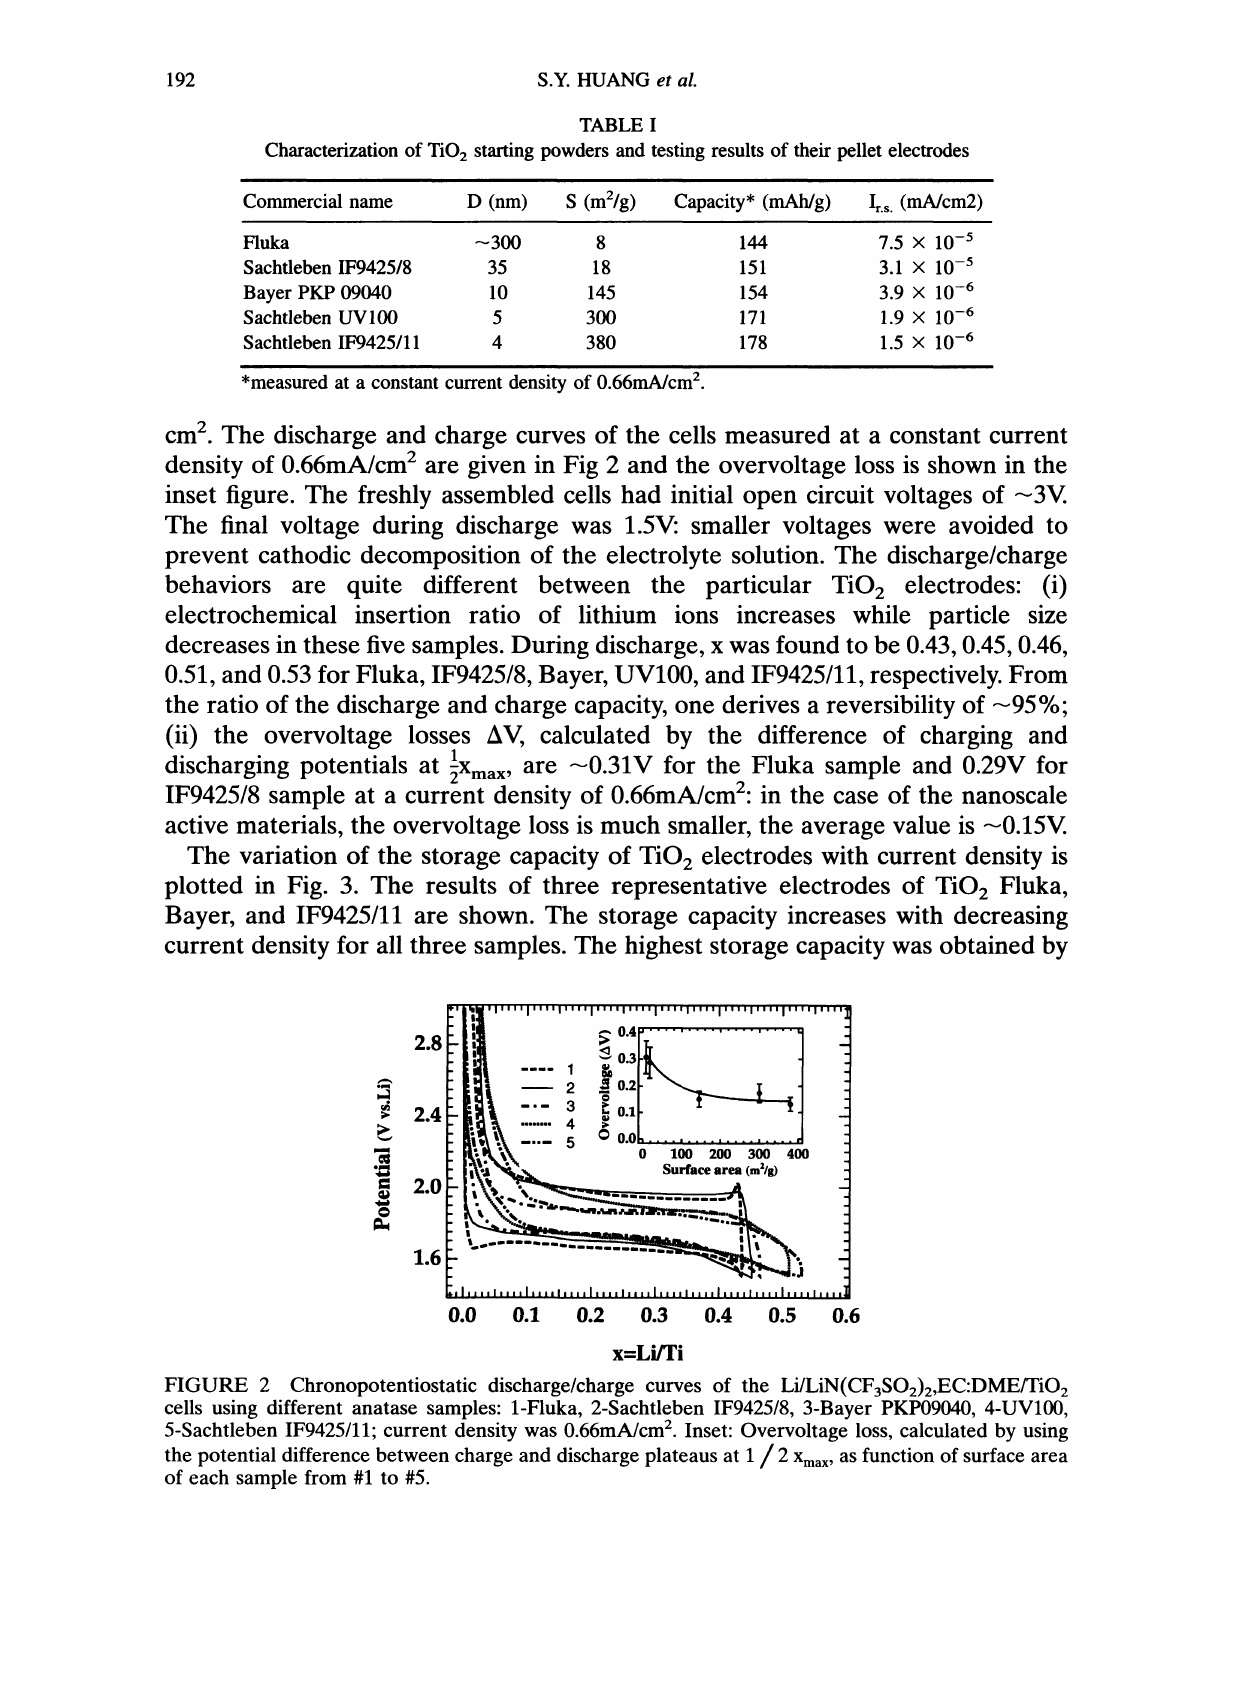
Characterization of TiO starting powders and testing results of their pellet electrodes